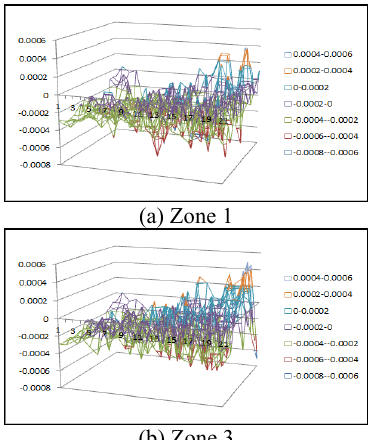
Figure 5 Error distributions of two typical regional coordinate mapping models.